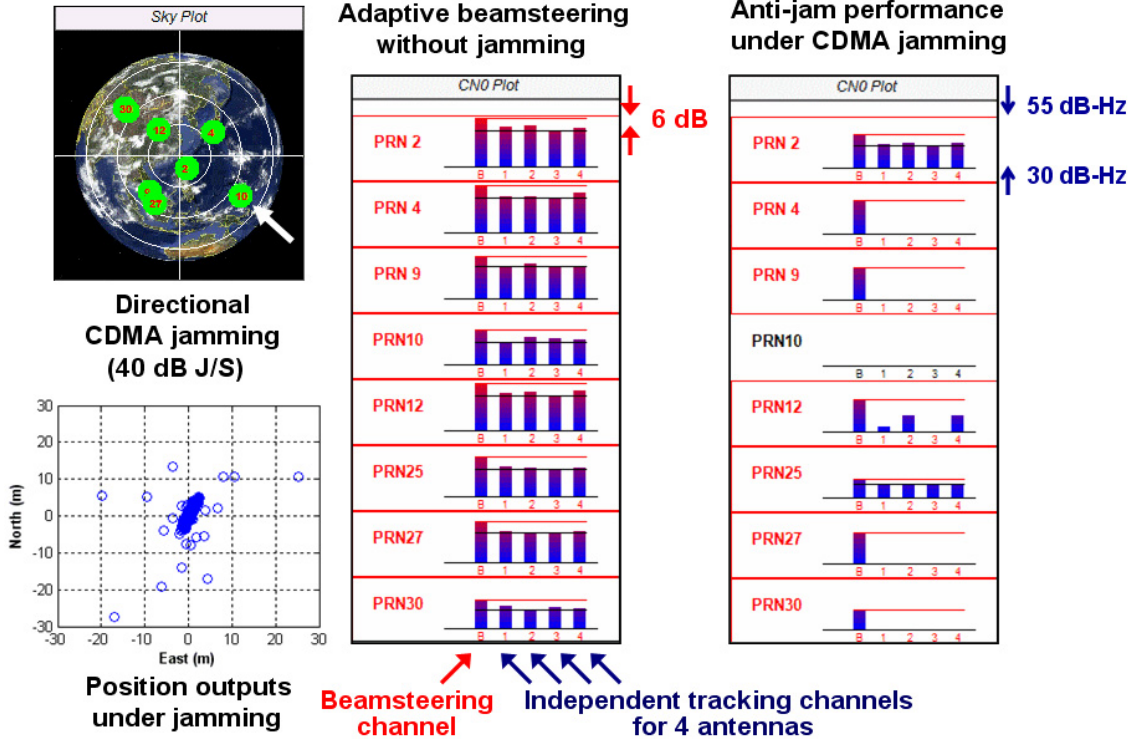
Figure 9. Anti-jam capability of GPS SDR for CRPA under synthesized CDMA